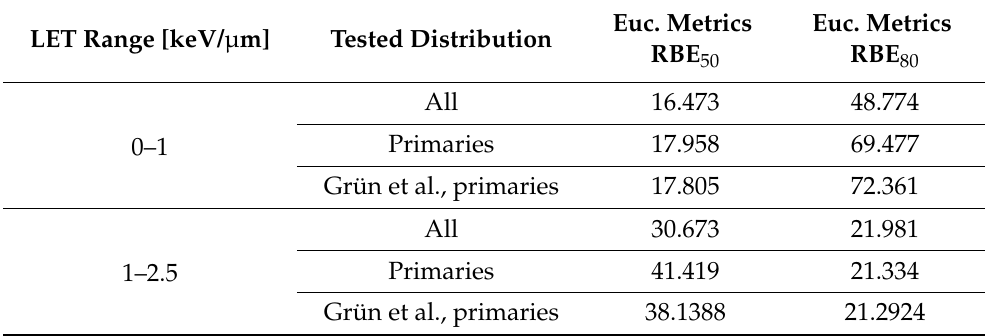
Table A2. Euclidean metrics outcomes of Equation (A1), comparing experimental survival data from Grün et al. [10] and predicted values of this work considering all particles and only protons in the case of RBE 50 and RBE 80 (Figures 9–11).